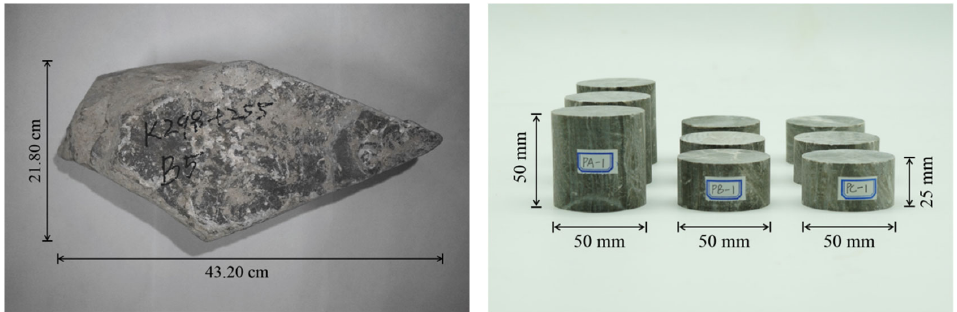
Figure 3. Gypsum rock and laboratory rock samples. Table 1. Dimensions of gypsum rock samples.